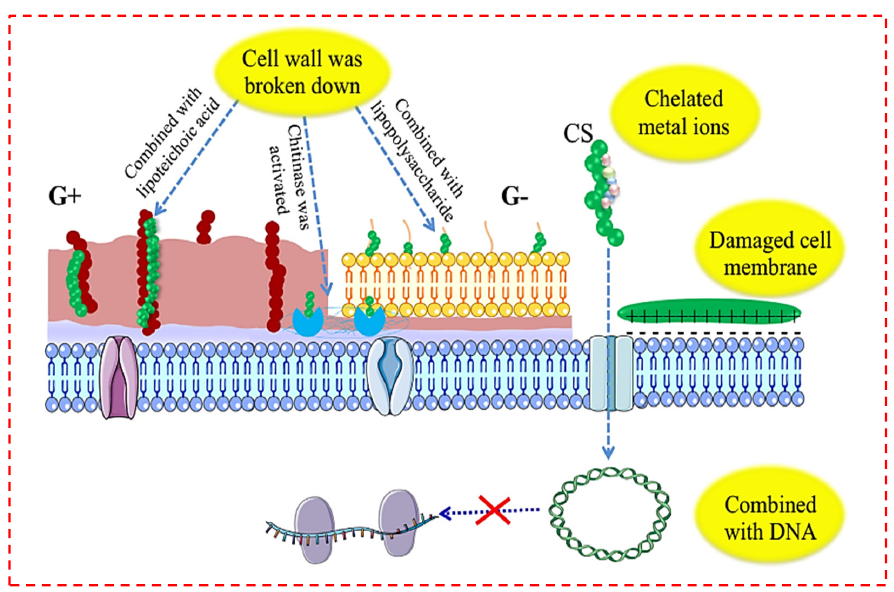
Figure 7. Antibacterial mechanism of chitosan and its derivatives [129].